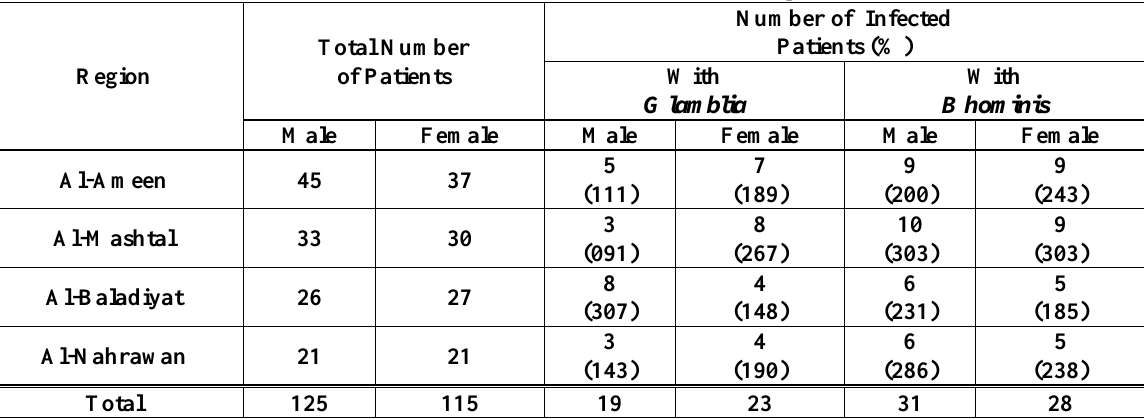
Table (4): Total number and number of male and female patients infected with G lamblia and B hominis within the four regions† Total Region